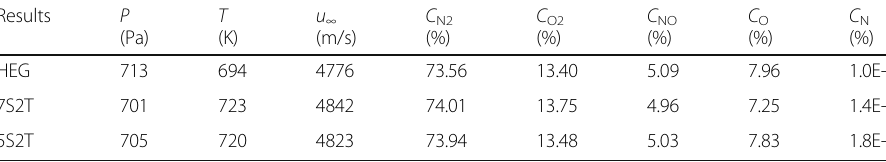
Table 6 Comparison of flow parameters in the HEG nozzle